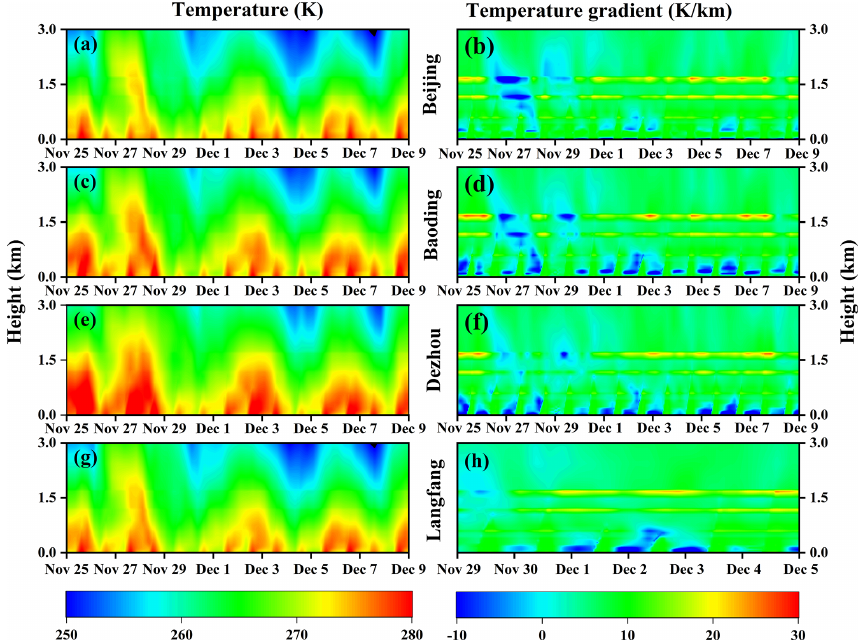
Figure 4. Time series of vertical temperatures (a, c, e, g) and temperature gradients (b, d, f, h) from Beijing (a, b) , Baoding (c, d) , Dezhou (e, f) , and Langfang (g, h) simulated by the WRF-Chem model.